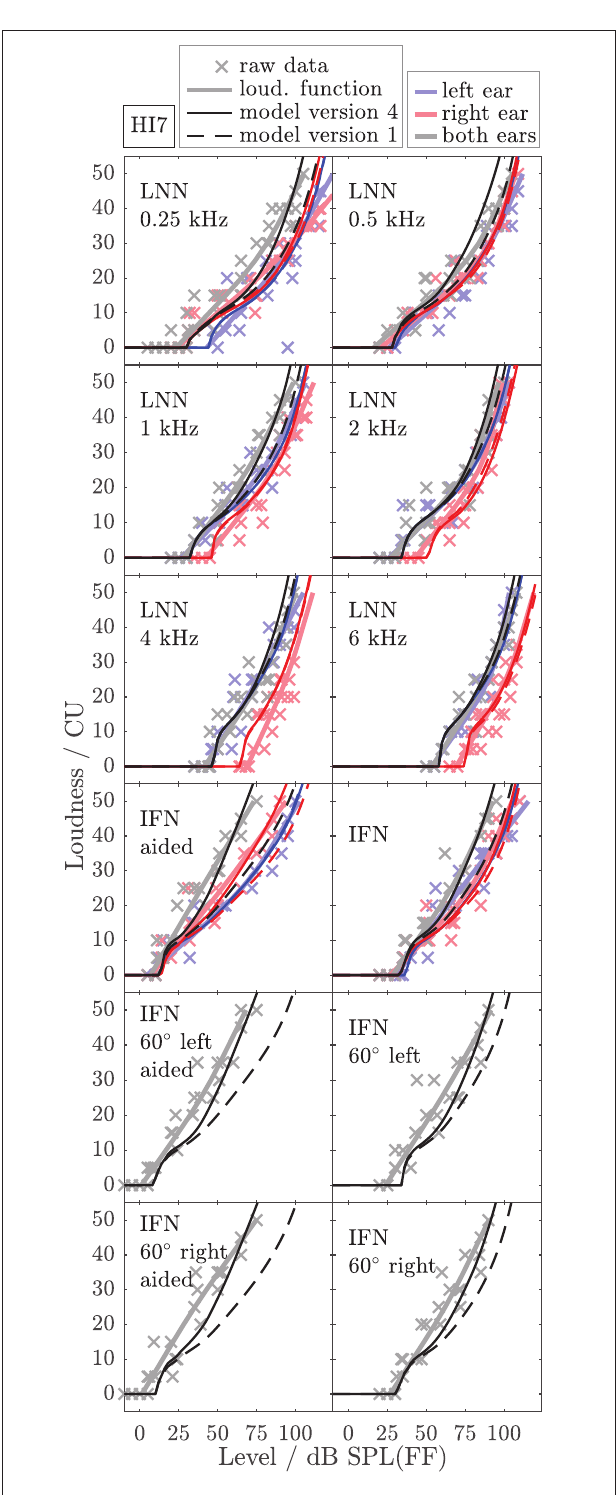
FIGURE 7 | As Figure 6 but for listener HI7.